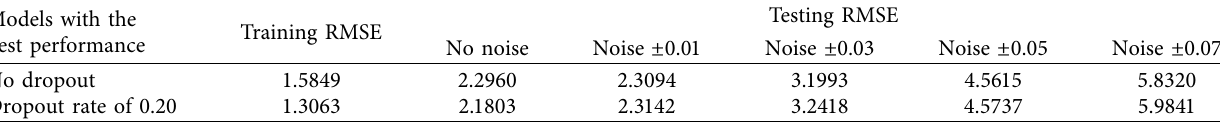
Table 3: Comparison of LSTM prediction models with the best performance. Models with the best performance Dropout rate of